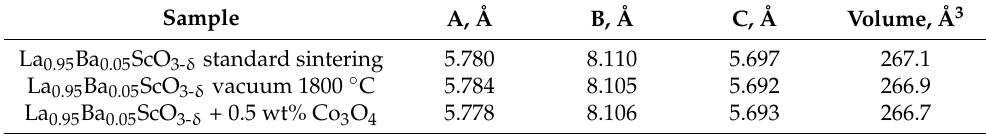
Figure 6. XRD patterns of La 0.95 Ba 0.05 ScO 3- δ samples obtained after standard sintering (1650 ◦ C), vacuum sintering (1800 ◦ C), and sintering with 0.5 wt% Co 3 O 4 additive (1650 ◦ C). Table 1. Unit cell parameters of La 0.95 Ba 0.05 ScO 3- δ samples sintered in various ways. Sample A, Å B, Å C, Å Volume, Å